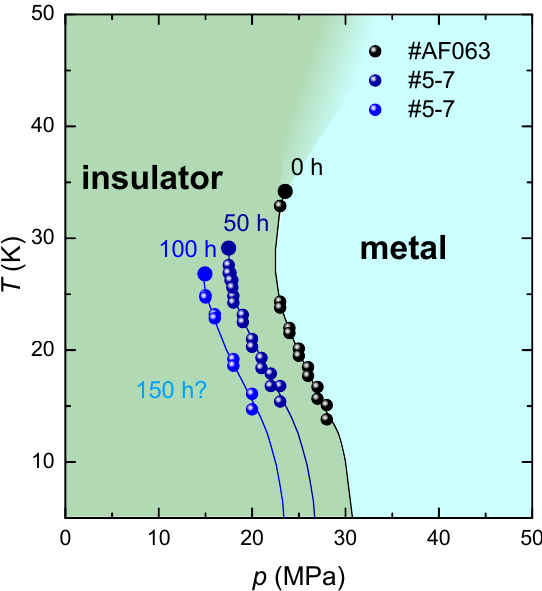
Figure 6. T - p phase diagram of the first-order Mott metal-insulator transition line of κ -(BEDT-TTF) 2 Cu[N(CN) 2 ]Cl upon increasing disorder which was intentionally introduced by X-ray irradiation. Black circles correspond to the phase transition line obtained from measurements (not shown) on a pristine sample of batch #AF063. Dark blue and light blue circles correspond to the phase transition line obtained from measurements on the same sample of batch #5-7 after exposure to X-ray for 50h and 100h, respectively (see Figure 5). Note that pairs of data points taken at the same p value correspond to the position of the jump upon warming and cooling. The lines are guides to the eyes. In case of 150h no discontinuities in R ( T , p ) could be resolved signaling the absence of a strong first-order phase